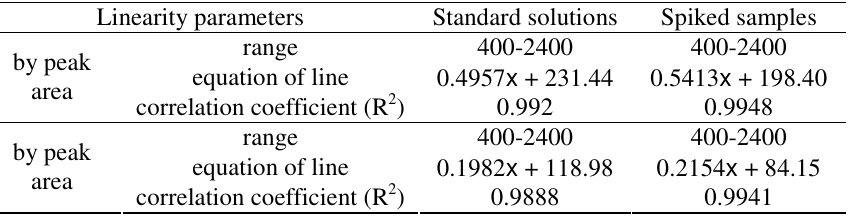
Table 1. Linearity and regression